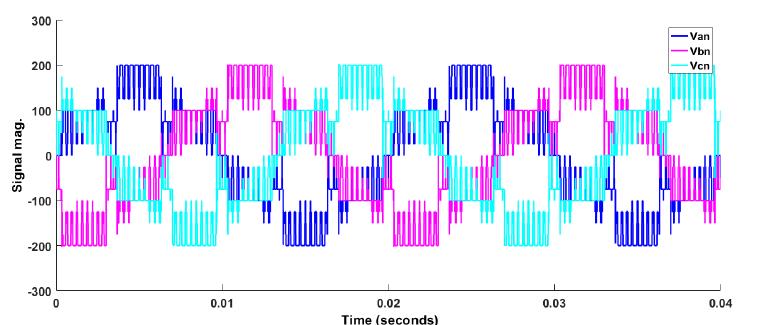
Figure 11. AHMMC output phase voltages at M f = 1.